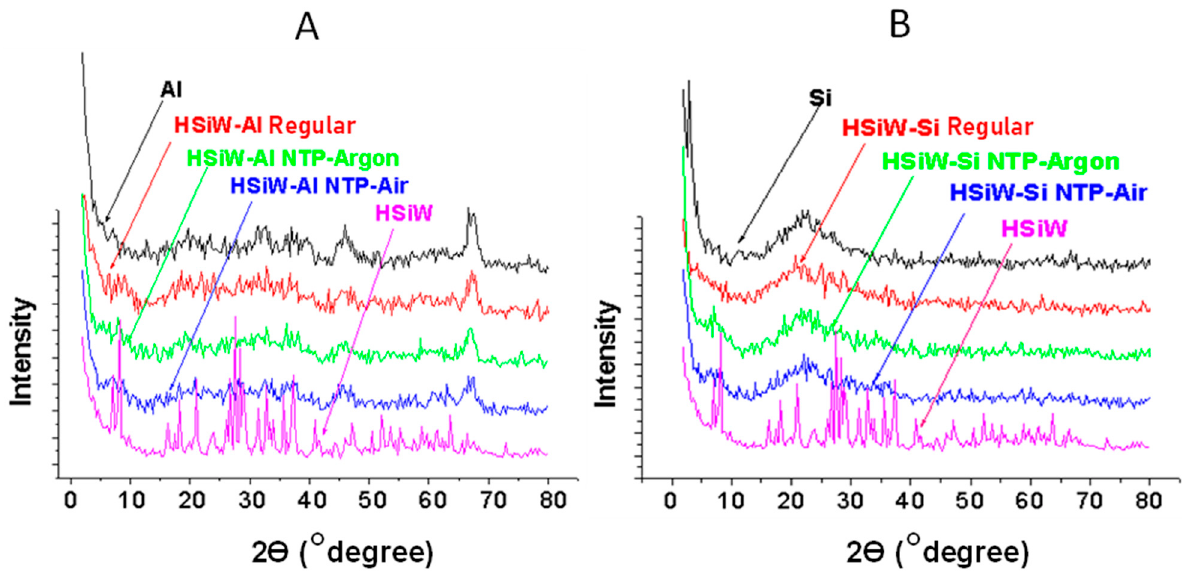
Figure 1. XRD patterns of ( A ) Al-supported and ( B ) Si-supported catalysts together with the respective blank support and HSiW powder.